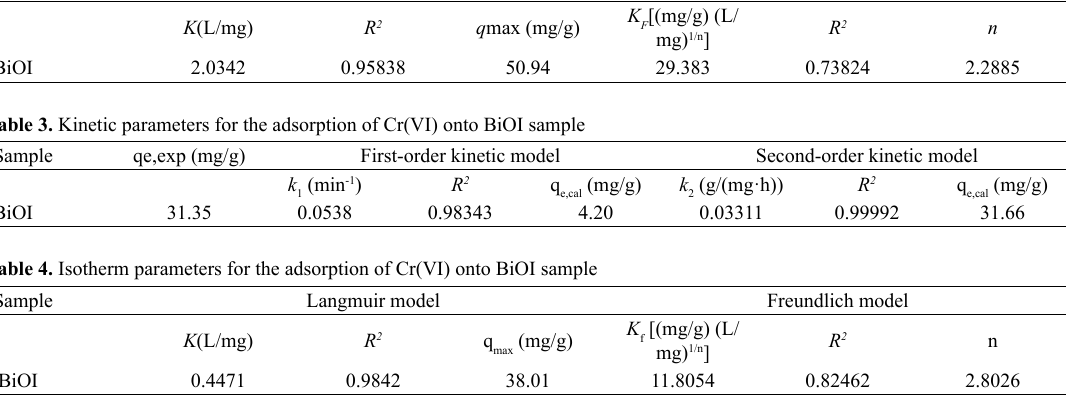
Figure 6. Time-dependent Cr (VI) concentration variation curve (a) and adsorption isotherms (b) over flower-like BiOI microspheres Table 2. Isotherm parameters for the adsorption of RhB onto BiOI sample Sample